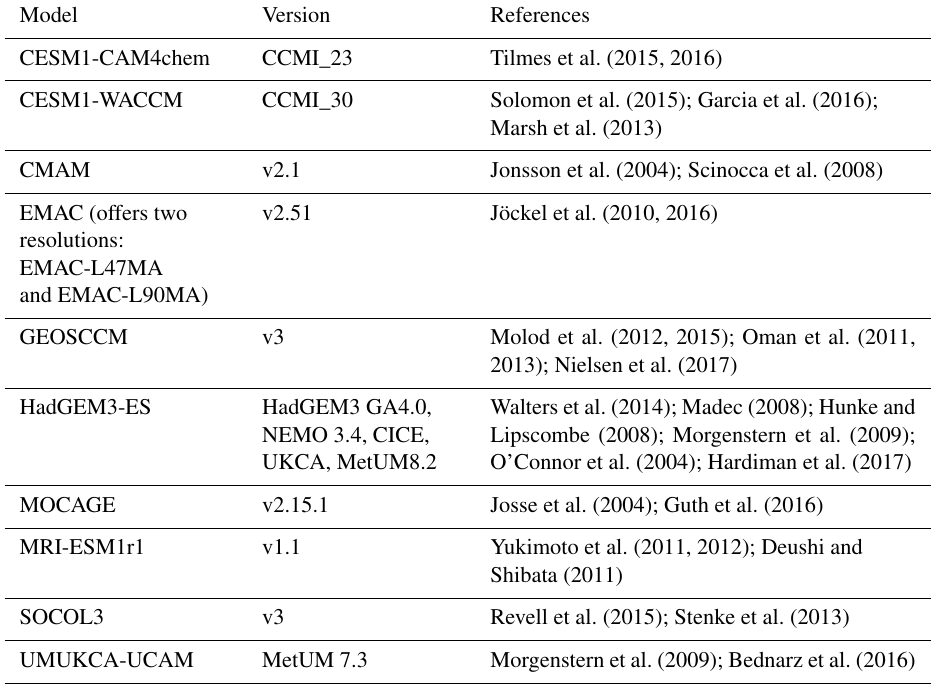
∗ The table refers to Table 2 in Morgenstern et al.